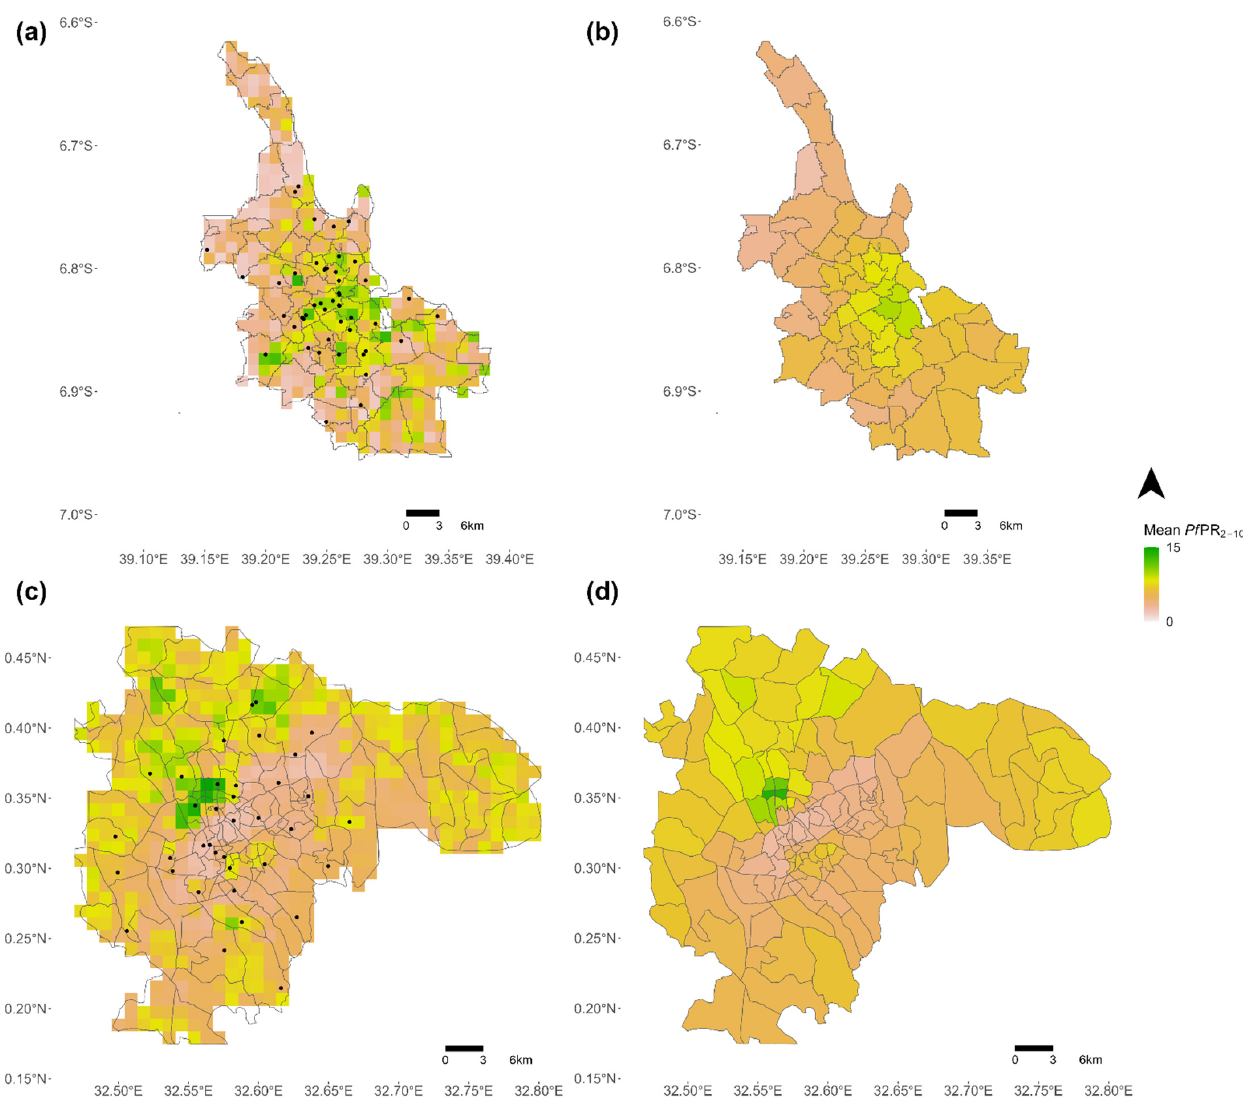
cross-validation. Figure 3 shows the predicted Pf PR 2 − 10 maps for Dar es Salaam and Kam- pala at 1 km raster level (Figure 3a,c) and aggregated by administrative unit (Figure 3b,d).